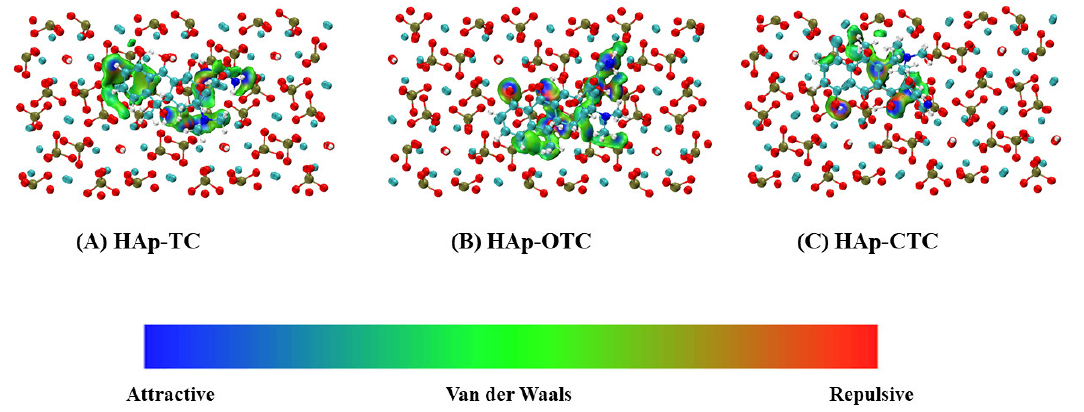
Figure 6. IGM between the two fragments of TCs and HAp.